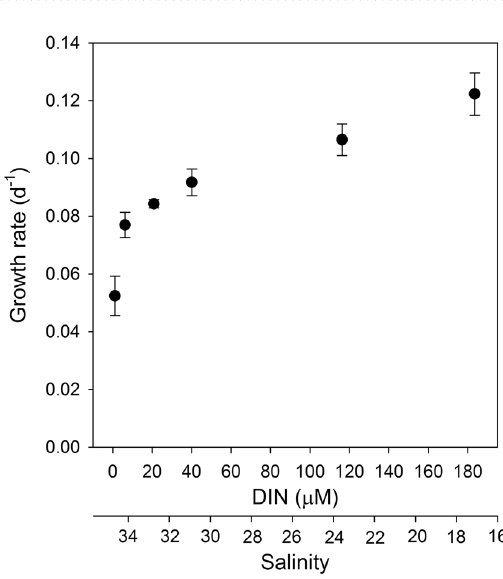
Table 2. The initial conditions of temperature, irradiance, salinity, and nutrients at different mixing ratios between open-ocean seawater and fresh groundwater (FGW) from April 26 to April 30, 2016, in mesocosm experiments. * Irradiance data were obtained from Korea Meteorological Administration.